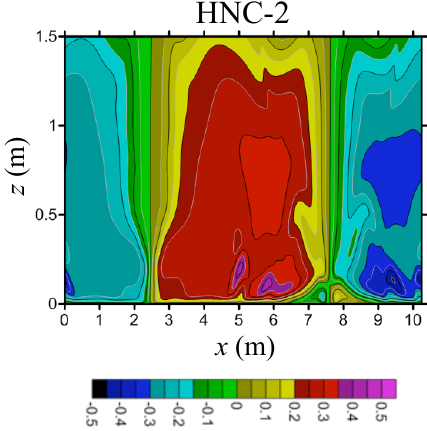
Figure 6. Vertical cross section of u from HNC-2, the numerical simulation with homogeneous Neumann condition for pressure in the second test case. Colour bar units are ms − 1